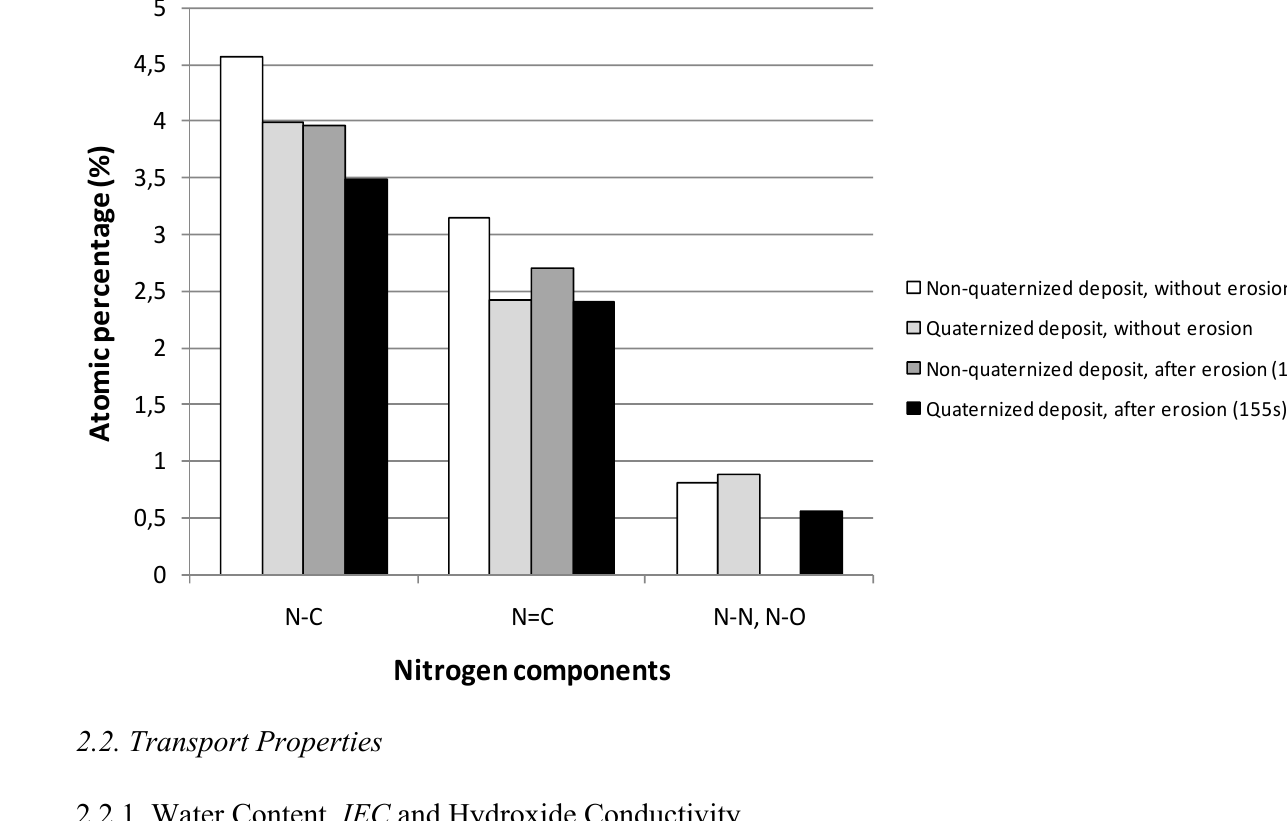
peak before and after 1s = 40 W, DC = 10% and w